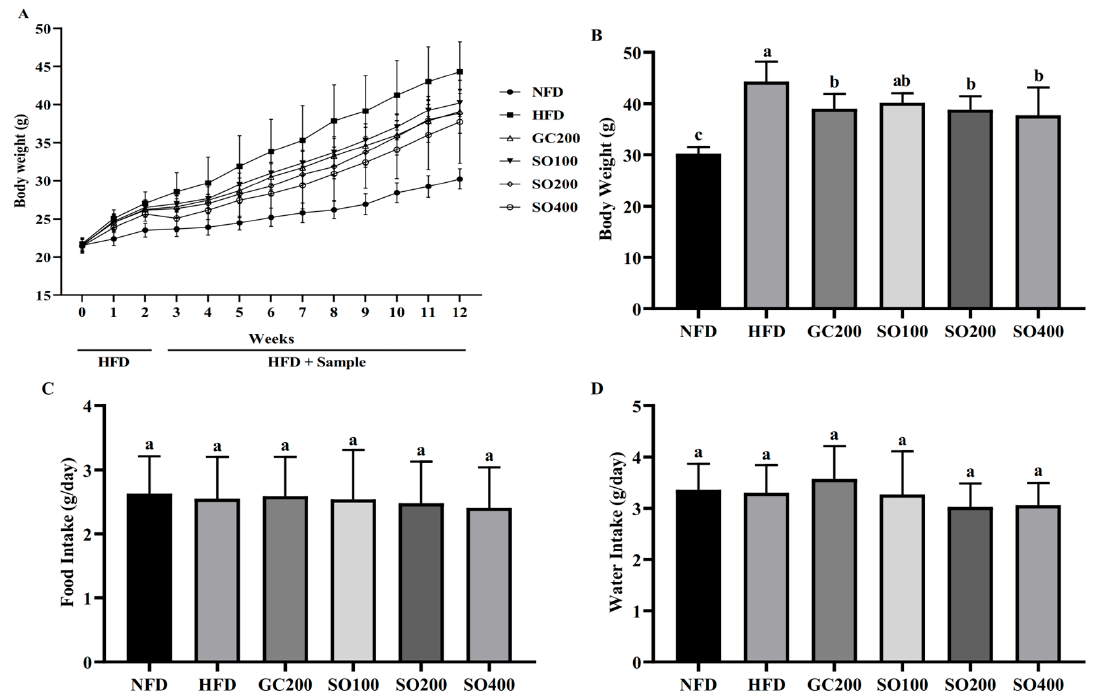
Figure 4. Effects of SO on body weight and diet in HFD-induced obese mice: ( A ) body weight change trend of mice during the experiment; ( B ) final body weight of mice at the end of the experiment; ( C , D ) food intake and water intake of mice during the experiment. GC200, HFD supplemented with 200 mg/kg/day of GC; SO100, HFD supplemented with 100 mg/kg/day of SO; SO200, HFD supplemented with 200 mg/kg/day of SO; SO400, HFD supplemented with 400 mg/kg/day of SO. Values are expressed as mean ± SD of experiments. Different letters indicate significant differences at the level of p < 0.05.